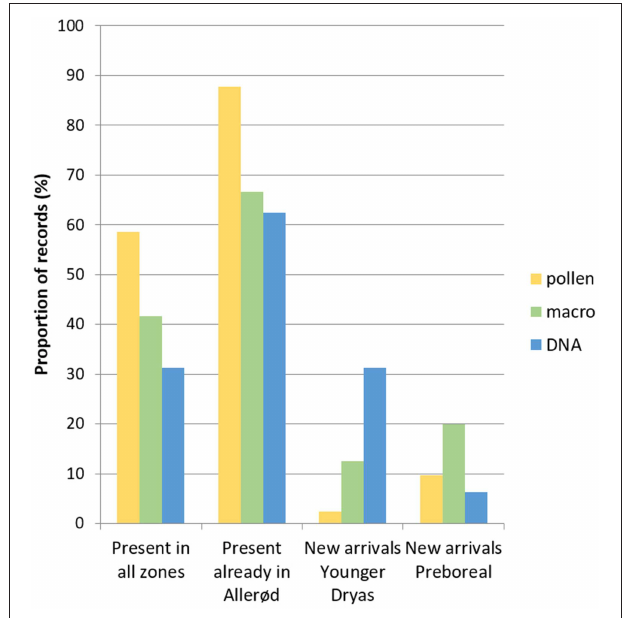
FIGURE 5 | Presences and arrival of taxa (in percentage) detected in pollen, macrofossils and ancient DNA analyses.